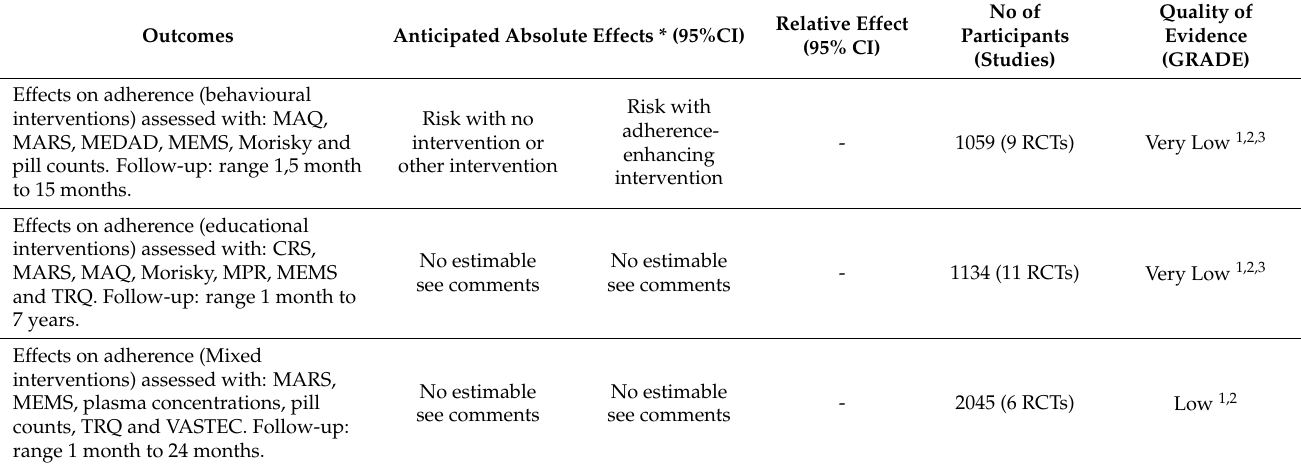
Table 6. Risk of bias assessment and quality